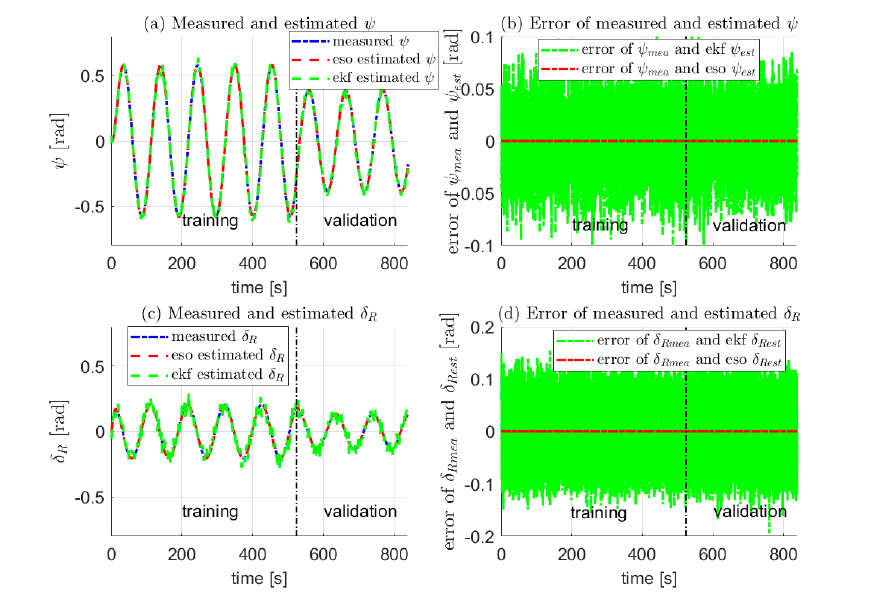
Figure 4. Measurements and estimates of heading angle ψ and rudder angle δ R of the patrol vessel. The data on the left side of the black dotted line are training samples and on the right side are validation